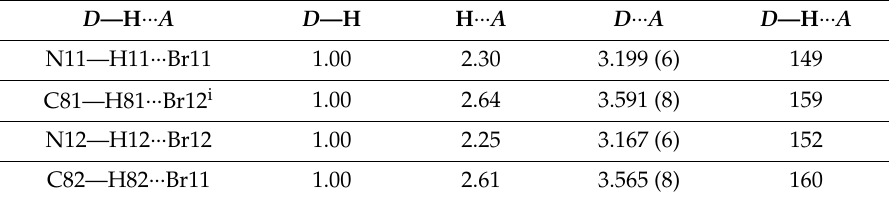
Figure 8. Part of the crystal structure of Compound 3 viewed along the a axis, showing H-bonding Table 4. Hydrogen-bond geometry (Å, ◦ ) for Compound 3 . between neighboring ions (dashed lines). Symmetry code: (i) x , y , z − 1. Table 4. Hydrogen-bond geometry (Å,°) for Compound 3 .